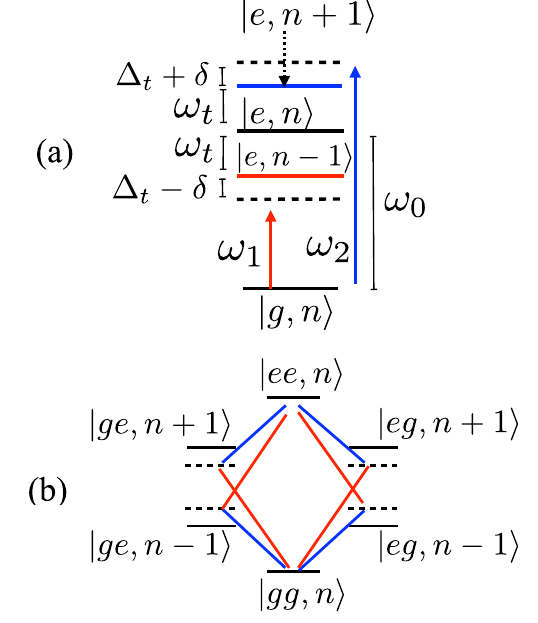
Fig. 17 The Mølmer–Sørensen scheme. a We shine two lasers at fre- quencies ω 1 and ω 2 close to the red and blue motional sidebands at ω ± ω t . Different detuning of the laser frequencies from the motional 0 sidebands give rise to different qubit interactions, as described in the text. b Physical picture for the emergent Mølmer–Sørensen interaction. Ions scatter from | gg , n (cid:7) to | ee , n (cid:7) (also from | ge , n (cid:7) to | eg , n (cid:7) ) either by emitting and re-absorbing a virtual phonon in the weak coupling case, Ω (cid:2) Δ t , or by constructive interference of four paths at special times when the spin and motion decouple in the strong coupling case, Δ ∼ t